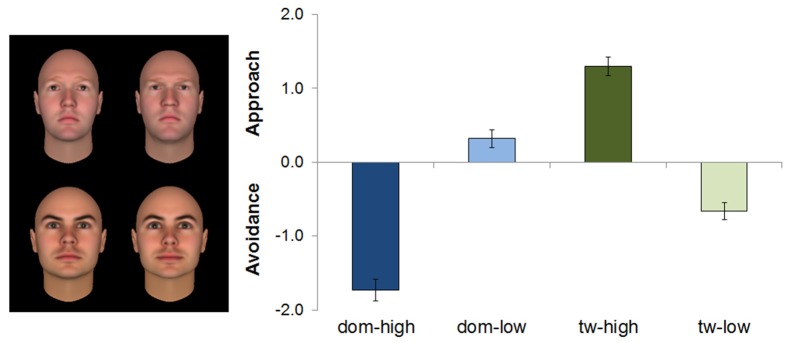
Mean ratings (with standard errors) of the rating task for faces varying in dominance (upper row: left: low, right: high) and trustworthiness (lower row: left: low, right: high), as derived from the Feature × Level interaction, n = 50. Positive scores indicate approach, whereas negative scores indicate avoidance tendencies. All means differ significantly from zero and from each other at p < 0.05. dom, dominance; tw, trustworthiness.